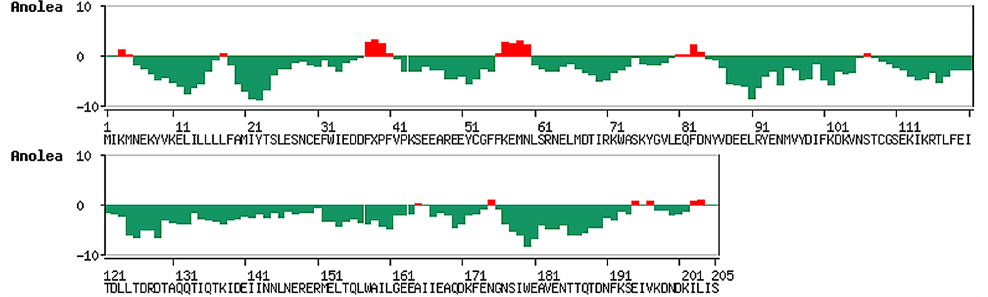
Figure 3. The packing quality of average MD structure analysed by ANOLEA [22]. High-energy amino acids show positive ANOLEA values (red bar) while low energy amino acids are with negative ANOLEA values (green